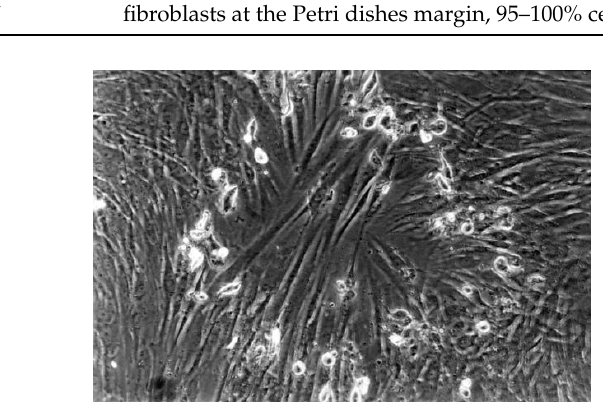
Figure 8. With Clearfil SE Bond (No. 4), the cell culture appears less dense than the cell control. Normal cells are predominating, but few rounded cells are found (100-fold magnification).